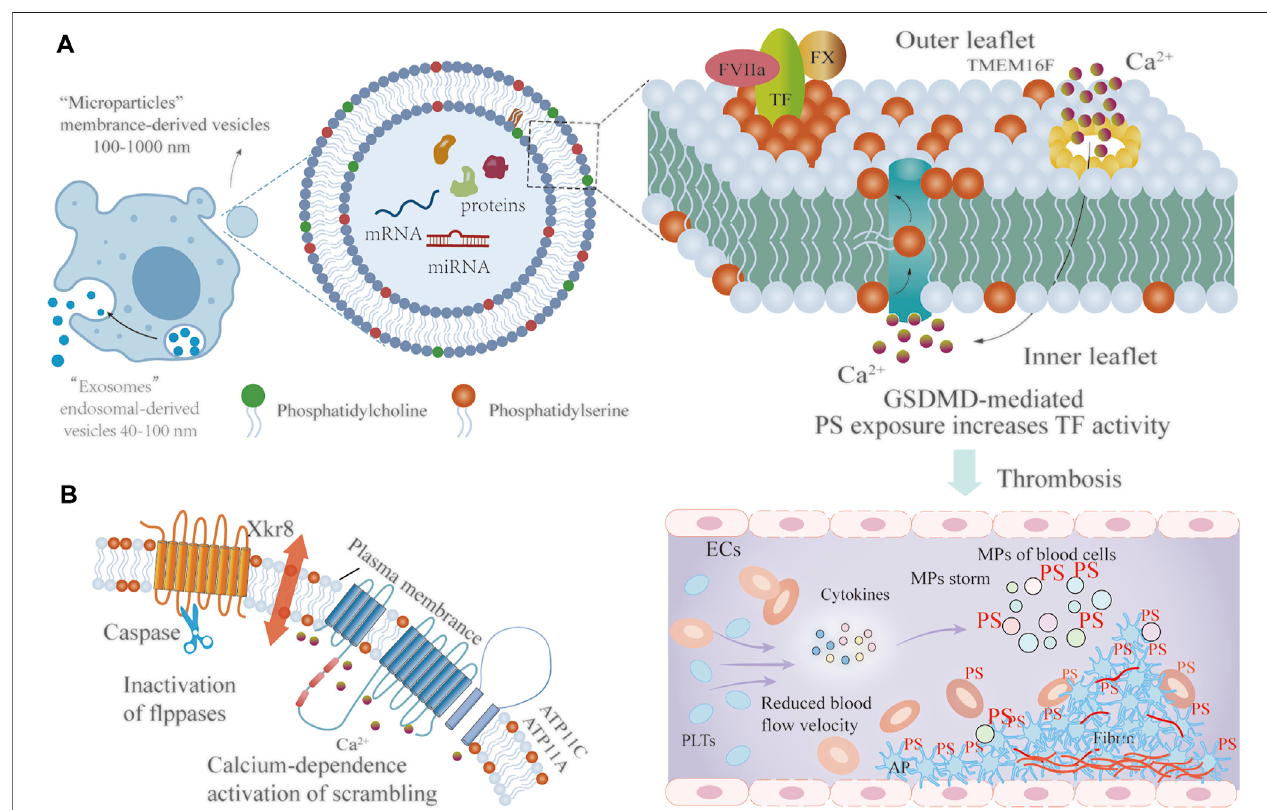
FIGURE 2 | The mechanism of PS externalization involved in coagulation. (A) Extracellular vesicles can be classi fi ed into two types according to size: MPs (approximately100 – 1000 nm)andexosomes(approximately40 – 100 nm).GSDMD formsapore,whichleadstocalcium in fl ux,TMEM16Factivation, andPSexposure, further enhancing the procoagulant activity of TF, and facilitating thrombosis (B) Owning to various stimuli, the caspase-dependent fl ippases ATP11A and ATP11C are inactivated while the calcium-dependent scramblase Xkr8 is activated, resulting in PS exposure on the outer membrane. FVIIa: Activated factor VII; TF: Tissue factor; FX: Factor X; PS: Phosphatidylserine; TMEM16F: Transmembrane protein 16F; ECs: Endothelial cells; PLTs: Platelets; AP: Activated platelets; RBCs: Red blood cells.; MPs: Microparticles; GSDMD: gasdermin